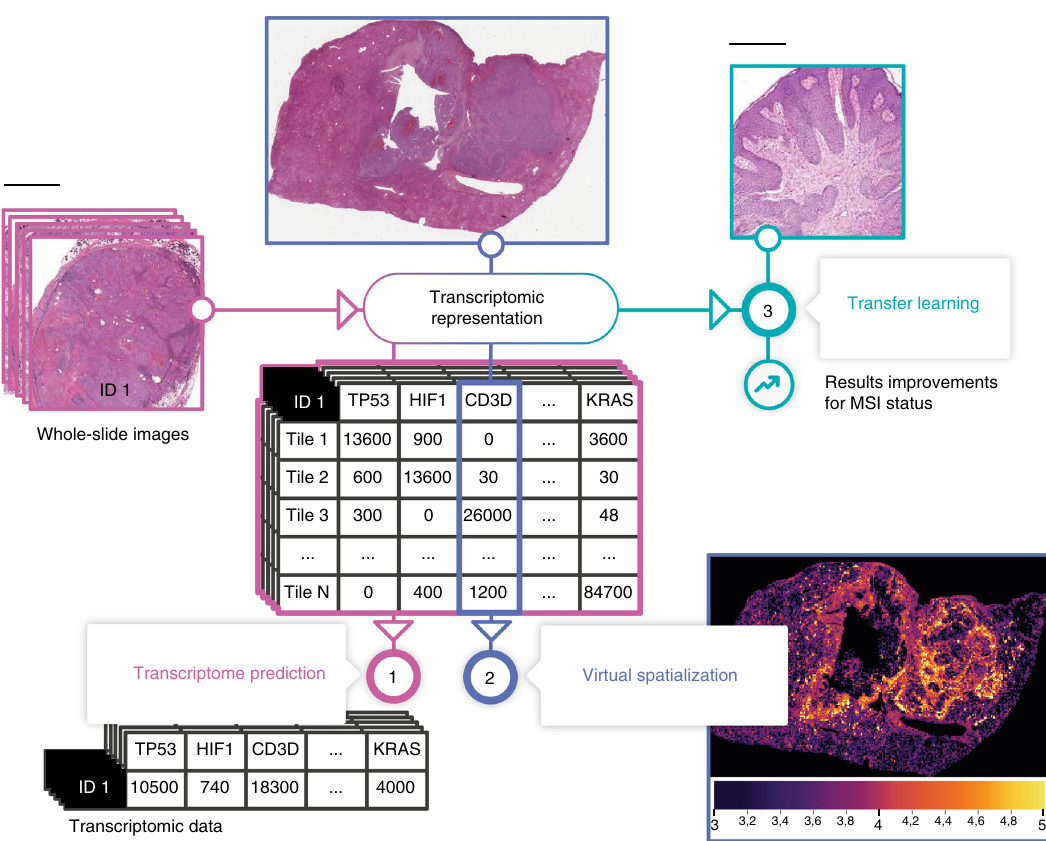
Fig. 1 Graphical abstract: Transcriptomic learning for digital pathology. Hematoxylin & eosin (H&E)-stained histology slides and RNA-Seq data (FPKM- UQ values) for 28 different cancer types and 8725 patients were collected from The Cancer Genome Atlas (TCGA) and used to train the neural network HE2RNA to predict transcriptomic pro fi le from the corresponding high-de fi nition whole-slide images (WSI). During this task, the neural network learned an internal representation encoding both information from tiled images and gene expression levels. This transcriptomic representation can be used for: (1) transcriptome prediction from images without associated RNA sequencing. (2) The virtual spatialization of transcriptomic data. For each predicted coding or noncoding gene, a score is calculated for each tile on the corresponding WSI, which can be interpreted as the predicted gene expression for this tile (even though the real value is available only for the slide). These predictive scores can be used to generate heatmaps for each gene for which expression is signi fi cantly predicted. (3) Improving predictive performances for different tasks, in a transfer learning framework, as shown here for a realistic setup, for microsatellite instability (MSI) status prediction from non-annotated WSIs. Scale bar: 5